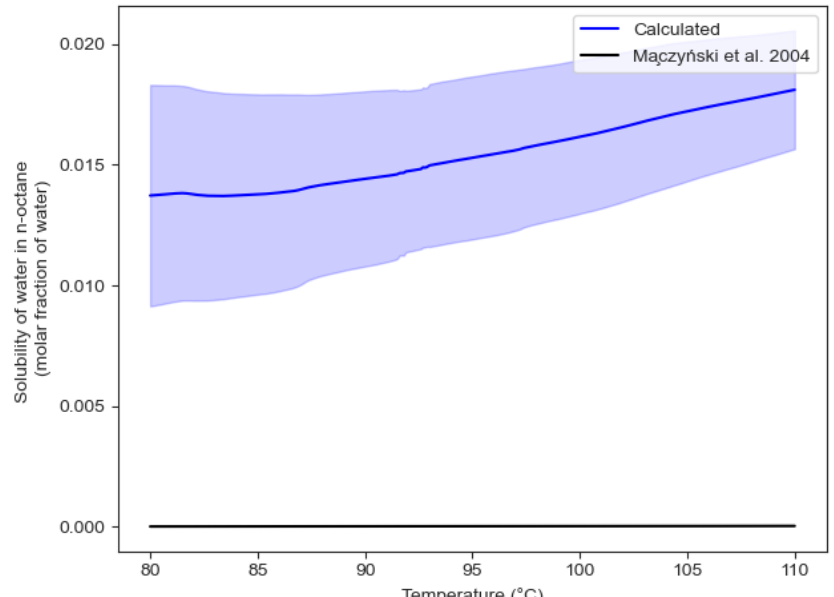
Figure 18. Solubility of water in n-octane in the temperature range of interest. Note: blue bands represent the 95% confidence interval.